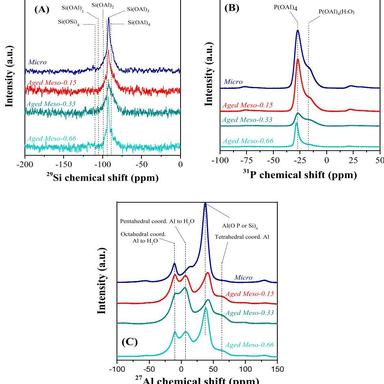
MNR spectra (a) 29Si, (b) 31P and (c) 27Al of hierarchical SAPO-34 chabazites synthesized with different amount of CTAB.